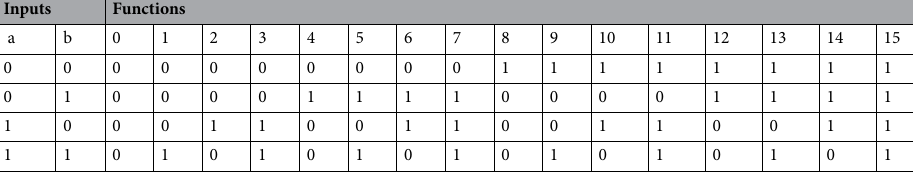
Table 1. Truth tables for binary functions. The truth tables of all possible unique binary ( k = 2 ) Boolean 2 k = 16 functions are shown ( 2 functions). The LTM can only compute monotonically-increasing Boolean functions (columns 0, 1, 3, 5, 7), where the first row equals zero, since the seed nodes are unlabelled (here 0 and 1 correspond to unlabelled or labelled, respectively). Thus, it cannot compute functions 2, 4, 6, or 8 to 15.